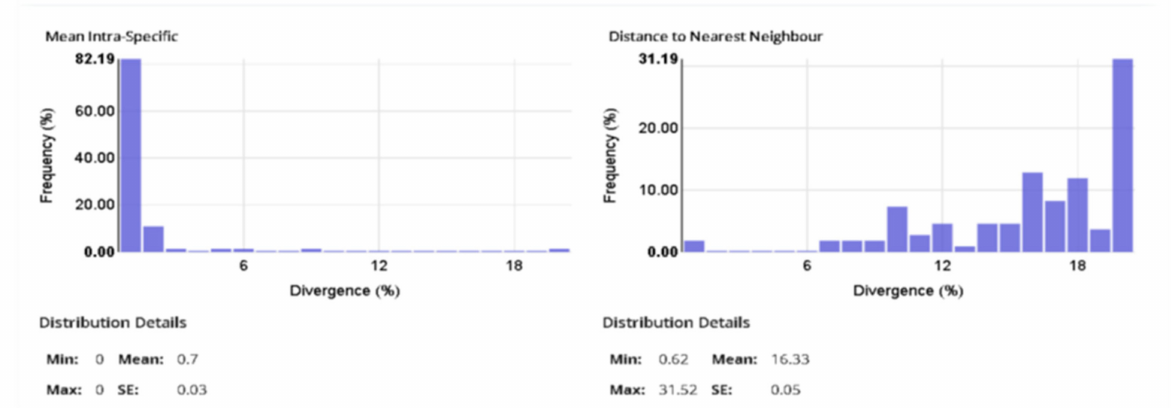
Figure 2. Sequence divergence in the COI Barcode for intraspecific and interspecific comparisons using the data included in this publication. Distance Model: Kimura 2 Parameter; Alignment: BOLD Aligner; Length filter >/= 300 bp; Excluded: contaminants and misidentifications, records with stop